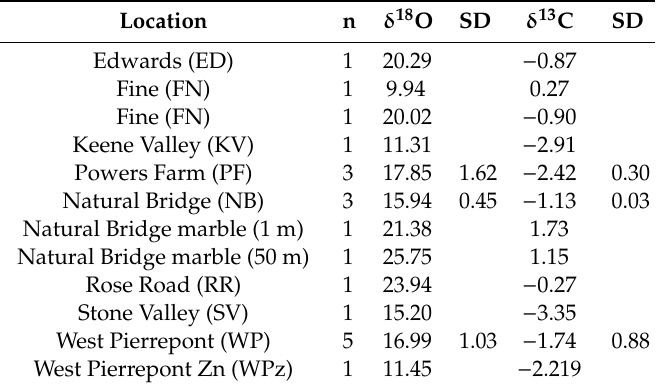
Table 3. Carbon and oxygen isotopes in